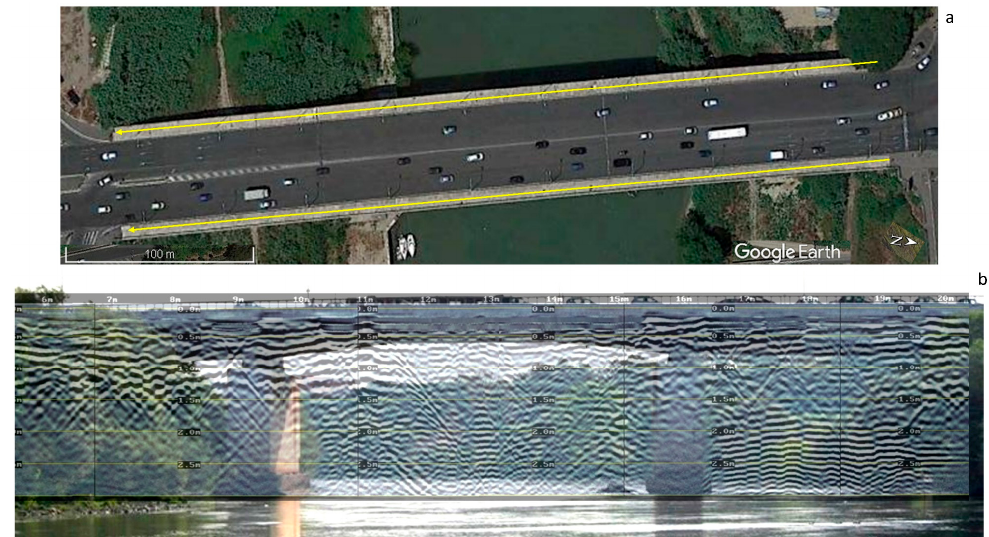
Figure 9. ( a ) The orientation of the profiles acquired along the two “wings” of the Marconi Bridge (Google Earth image); ( b ) is an overlap attempted to show a GPR profile showing the thickness of the “wings” and the penetration of the radar signal through the pylons and up to the surface of the river water below. Geosciences 2018 , 8 , x FOR PEER REVIEW 9 of 13